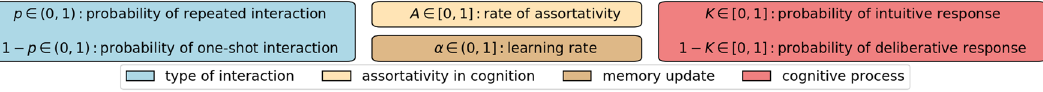
Figure 1. Overview of the model notation, with colors denoting the scope of